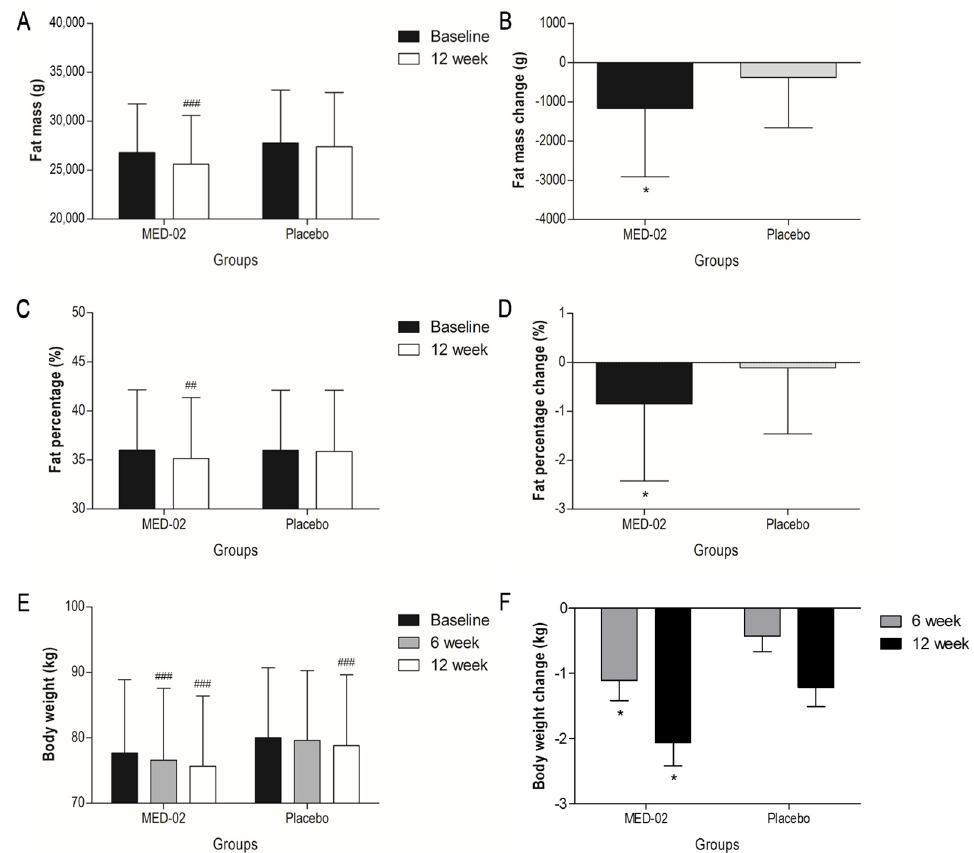
Figure 2. Changes in ( A , B ) body fat mass, ( C , D ) body fat percentage in the MED-02 and placebo groups were evaluated by DEXA at baseline and 12 weeks. ( E , F ) body weight changes in the MED-02 and placebo groups were evaluated at baseline, 6 weeks, and 12 weeks. There was no significant difference at the baseline between two intake groups. Values are presented as mean ± SD; ## p < 0.01 and ### p < 0.001 compared with baseline in each group by paired t -test; * p < 0.05 compared between groups by ANCOVA adjusted for sex, age, drinking, smoking, exercise, and site.